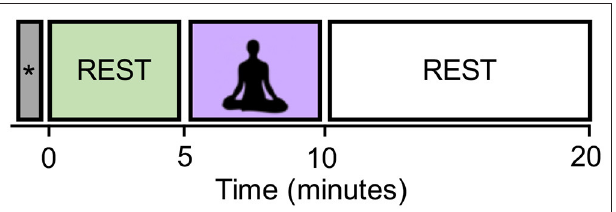
FIGURE 1 | The experimental design. The block labeled with the symbol “*” contains the dummy six volumes (with the duration of 15 s) acquired before the start of the first resting block. They were excluded from the analysis in order to eliminate the non-equilibrium effects of